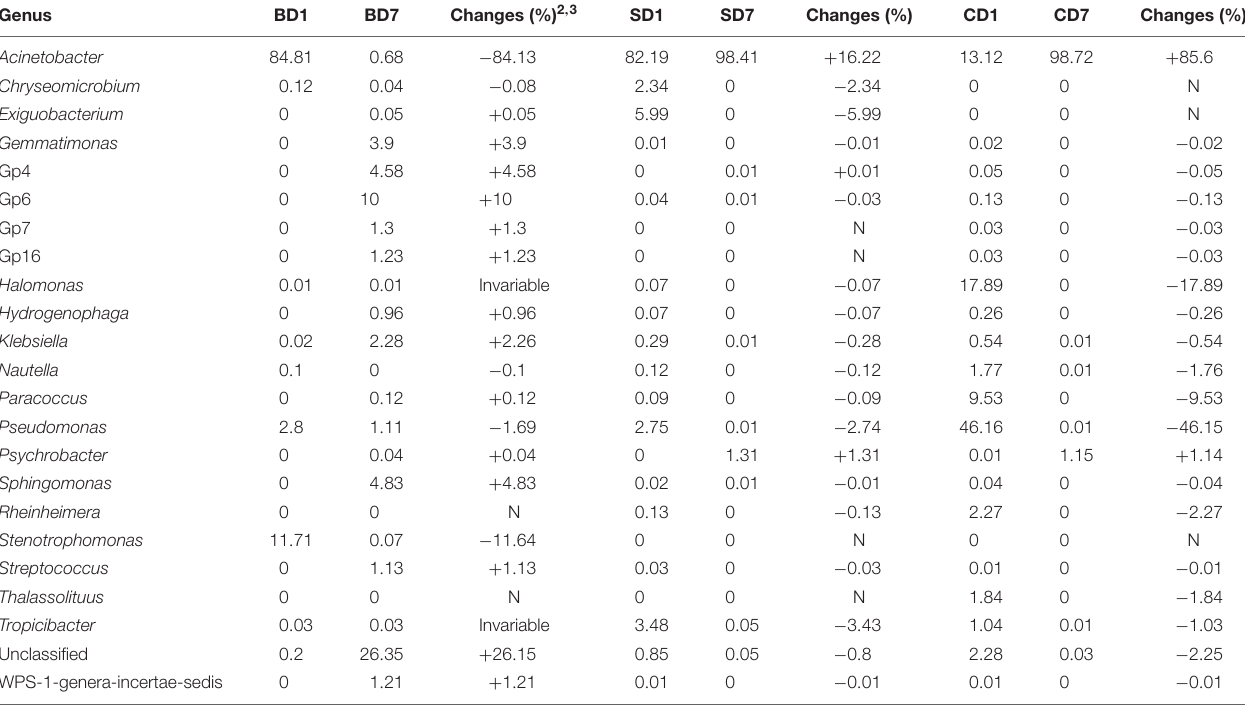
TABLE 7 | Changes of relative abundance of various major bacterial genera in each sample over the 7-day test period 1